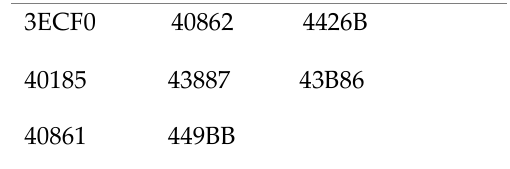
Table 2. Fuwangge Rockery Monitoring PS